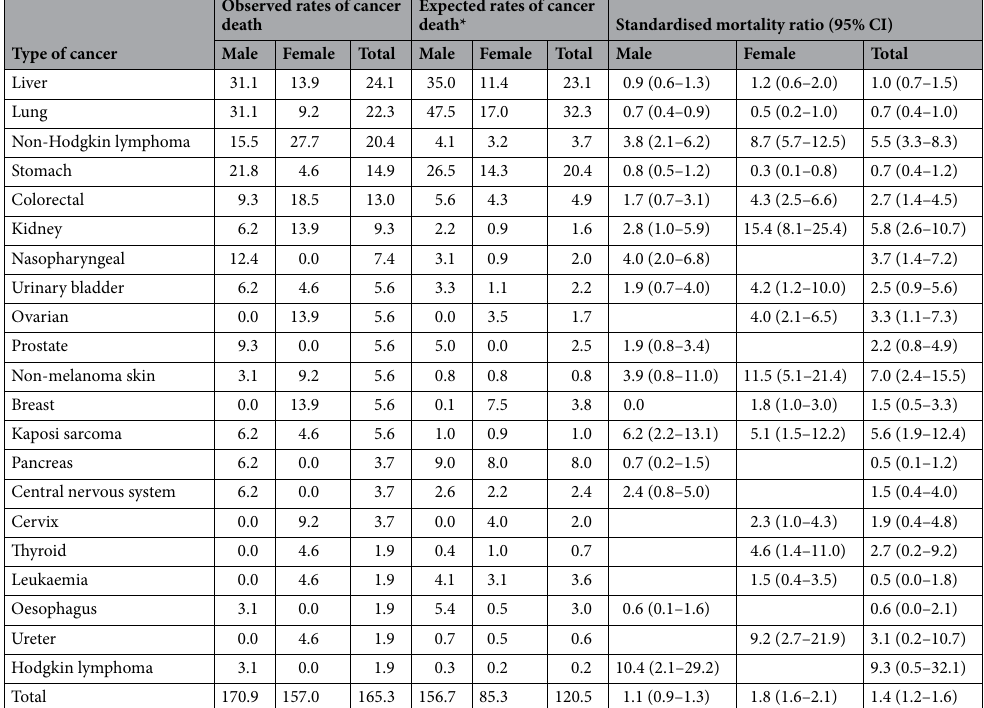
Table 4. Standardised mortality ratios according to the types of post-transplant malignancies. CI confidence interval. *The expected rates of cancer death are based on the general population in Korea, adjusted for age and sex.